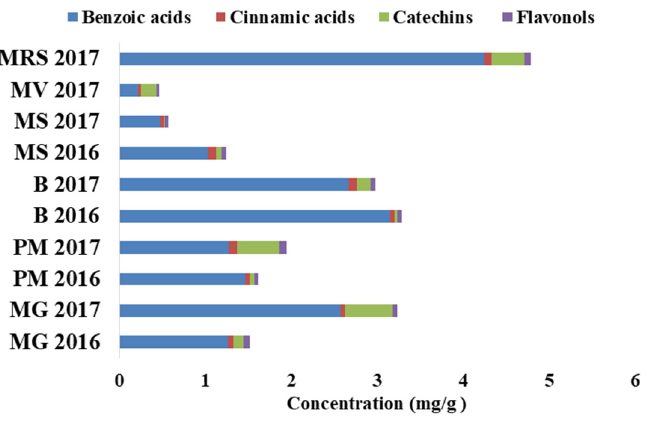
Figure 2. Polyphenolic profile of the analyzed chestnut cultivars harvested in 2016 and 2017 .